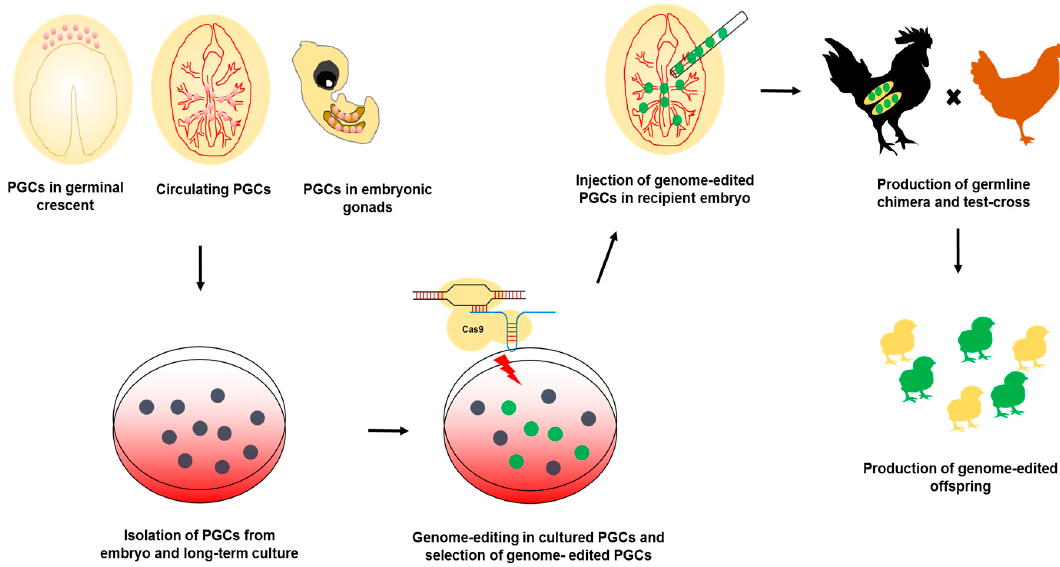
Figure 1. Schematic illustration of primordial germ cell (PGC)-mediated genome-editing in poultry. PGCs can be isolated from several stages of embryo and cultured in vitro. Genome-editing tools can be applied to cultured PGCs and genome-edited PGCs were enriched by using in vitro selection. The enriched genome-edited PGCs are injected into the bloodstream of recipient embryo and germline chimeras are produced. By mating with wild-type chicken, the genome-edited offspring finally produced.